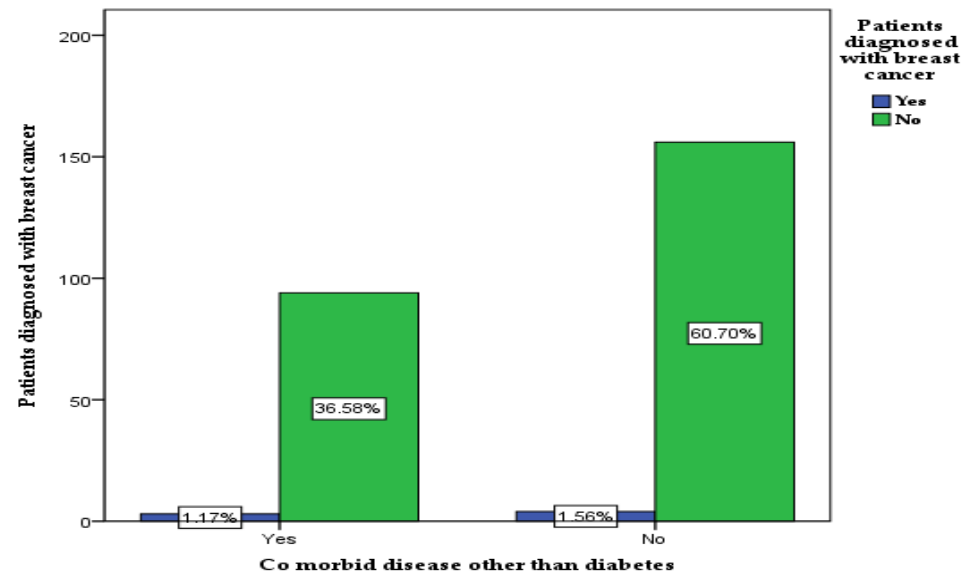
Figure 6. Frequency percentage distribution of relationship between comorbid disease and patients’ diagnosis of breast cancer ( p value 0.78).